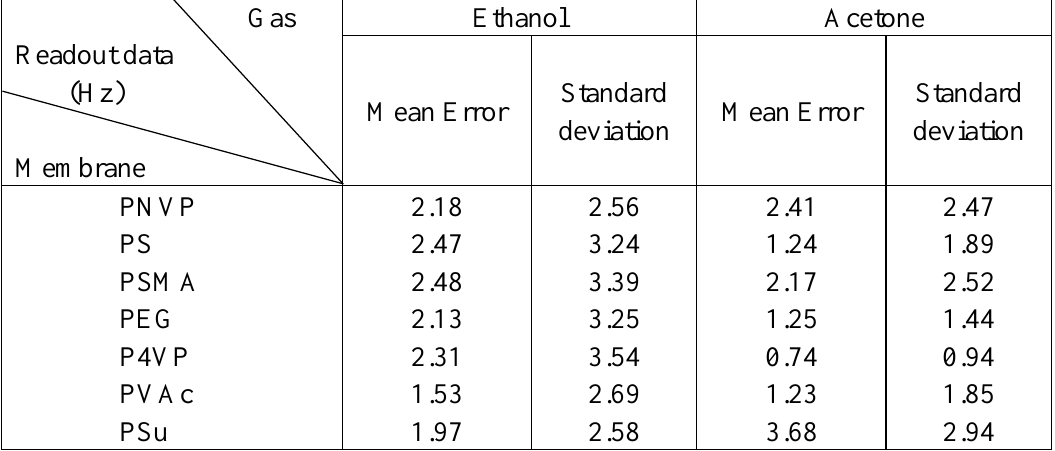
Table 3. Mean error and standard deviation of the two lists of